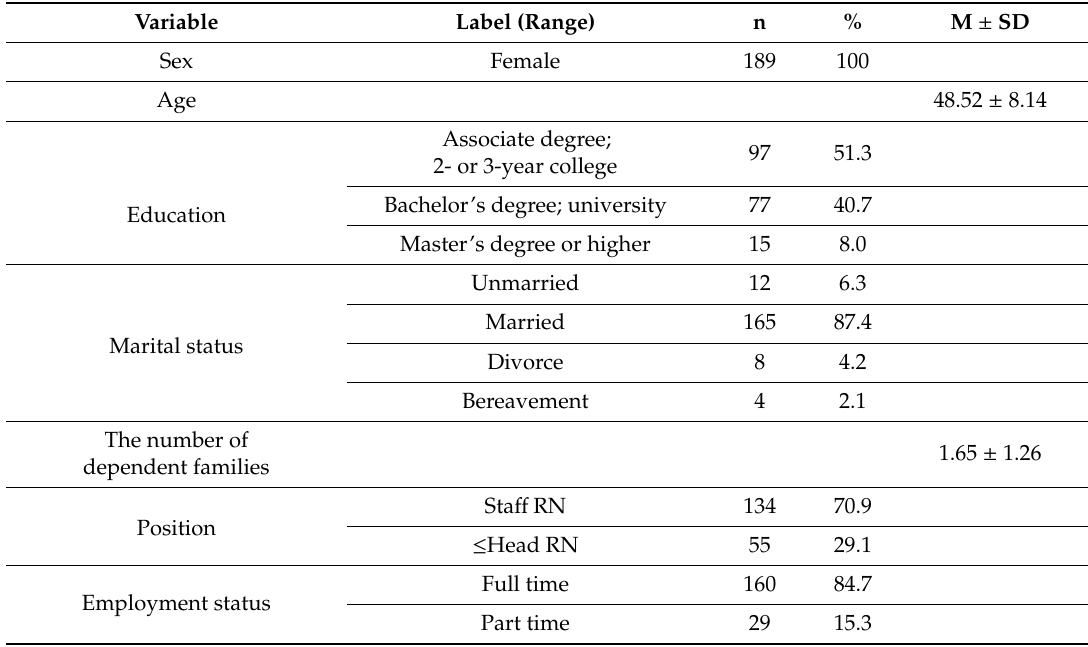
Table 1. Descriptive statistics for individual (resident nurse (RN))-level variables and intention to